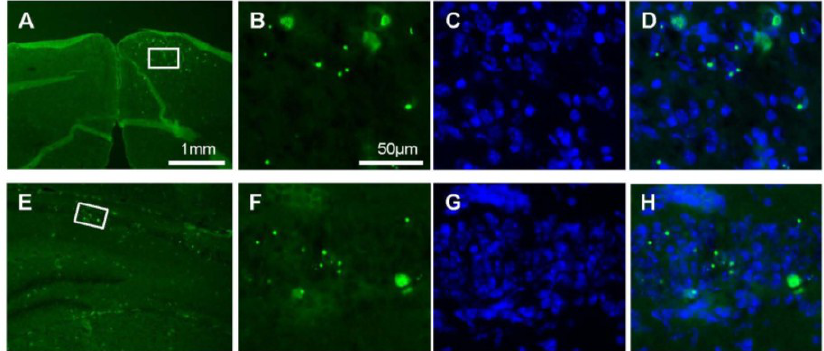
Figure 6. Nuclear detection of E1 protein in Dicer d/d mouse brain. Examples of immunofluorescent detection of E1 protein in the cortex (( A )–( D ); Bregma — 3.08mm) and hippocampus (( E )–( H ); Bregma — 2.3 mm) of Dicer d/d brain using CROMA 103 antibody. Magnifications of boxed regions illustrate E1 expression ( B ), ( F ), DAPI staining of the nuclear DNA ( C ), ( G ) and their colocalisation ( D ), ( H